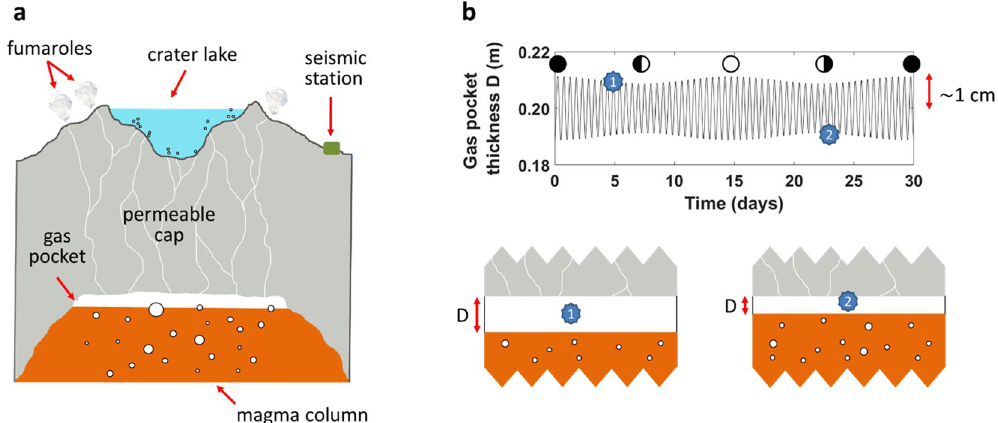
Figure 3. Fundamentals of our model. ( a ) Sketch of Ruapehu volcano during quiescence. Tremor-like pressure oscillations emerge spontaneously in subsurface gas pockets due to the intermittent supply of volatiles into the pocket and the transfer of gases through the porous cap 35,36 . ( b ) Periodic ascent and retreat of magma due to tidal squeezing of the magma plumbing system 1,2,5,6,31 ; this generates harmonic variations of the gas pocket thickness ( D ), which in turn affect the amplitude of the seismic signal 35,36 . Black, white, and half disks represent new, full, and quarter moon, respectively. Numbered blue stars represent a case with thick gas pocket and another case with thinner gas pocket.